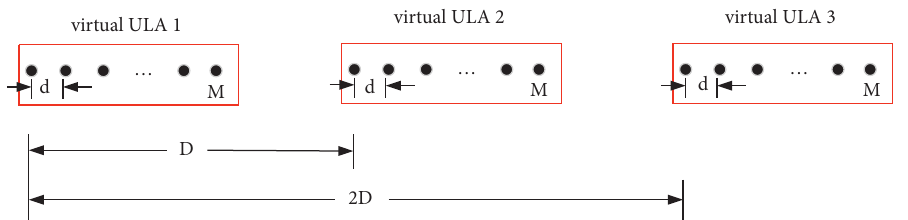
Figure 4: The schematic diagram of the virtual array of distributed super nested